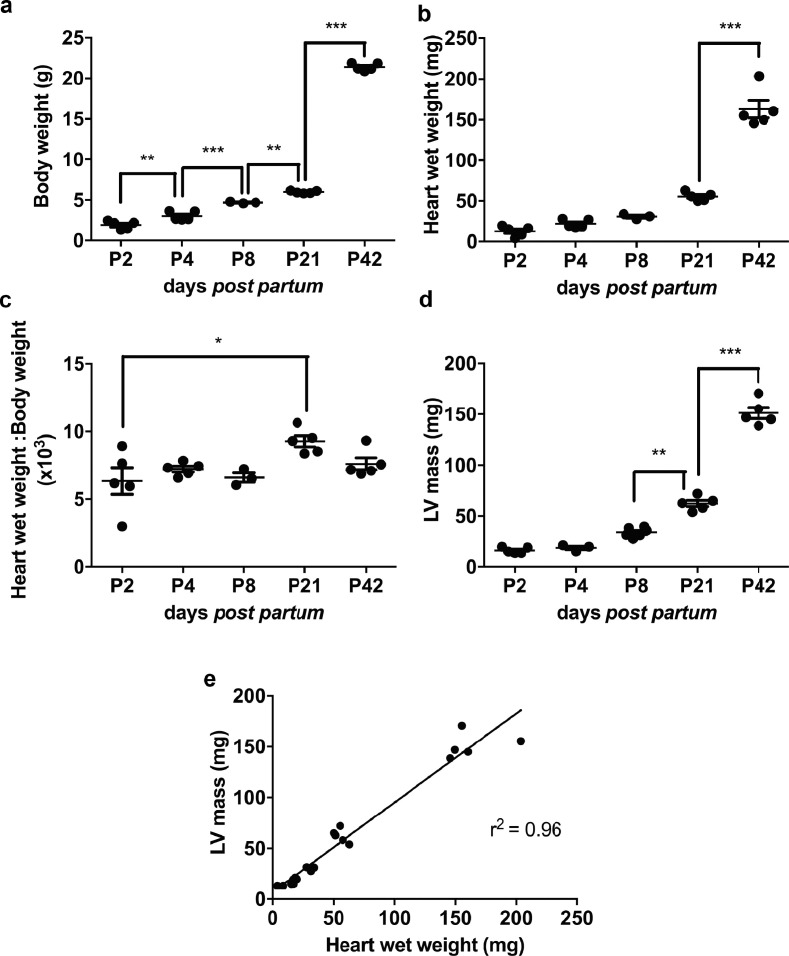
Measurements extracted with electrocardiogram-gated kilohertz visualisation (EKV) ultrasound imaging correlate with ex vivo measurements. Body weight (a) was measured before high-resolution in vivo ultrasound. Heart wet weight (b) was measured immediately after high-resolution in vivo ultrasound imaging after dissection and used to calculate heart to weight ratio (c). EKV B-mode allowed calculation of left ventricular (LV) mass (d). LV mass was plotted against heart wet weight for each animal and linear regression applied (e) to obtain the coefficient of determination r2. All measurements were performed at post-natal day 2 (P2), P4, P8, P21 and P42; n = 3–5/group. Results are presented as mean ± standard error of the mean; p value determined with one-way analysis of variance with Bonferroni post hoc test. *p < 0.05, **p < 0.01, ***p < 0.001.